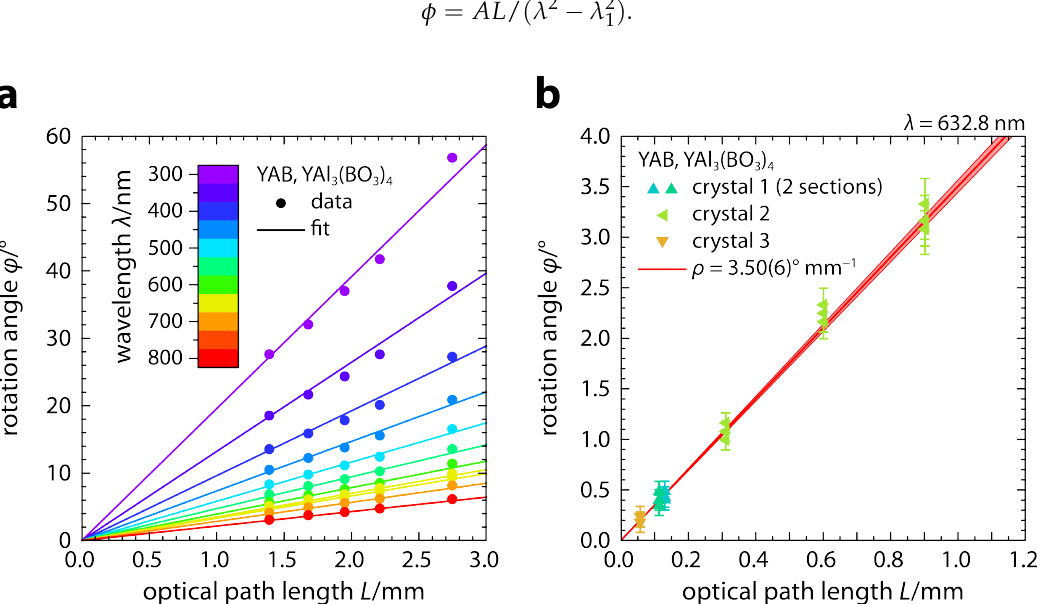
Figure 3. Optical rotation angles of YAB measured on domains with different optical path lengths. In ( a ), the lines show the result of simultaneously fitting a dispersion relation to the observed rotation angles at all wavelengths and path lengths shown in ( a ). The red line in ( b ) shows the fitting result of ( a ) for a wavelength of 632.8 nm. The shading indicates propagated uncertainties on fitted parameters. Note the linear relation between observed rotation angles and path lengths in ( a ) and the agreement of the fit with measurements at 632.8 nm on very thin domains in ( b